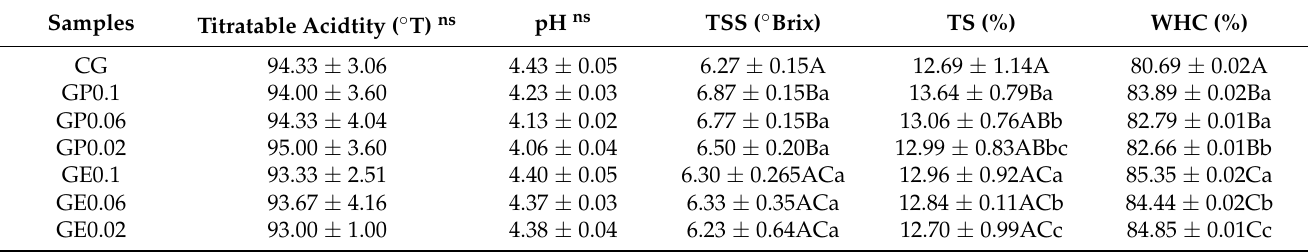
Figure 1. Viable cell counts in yogurt. Different capital and small letters indicate significant differences between and within groups, respectively ( p < 0.05). Table 1. Effects of GP or GE on physicochemical properties of